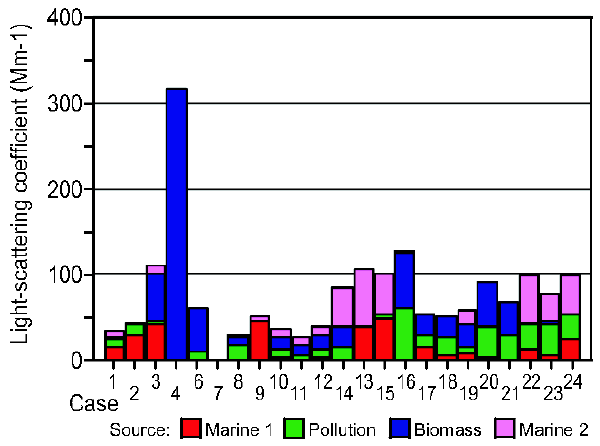
Figure 9. Source contributions to the aerosol light-scattering coefficient ( σ sp ) for each of the three sources to each of the samples taken during the CARMA III Fig. 8. Source contributions to the aerosol light-scattering coeffi- study. The samples shown were taken consecutively between August 6 th and 26 th , cient ( σ sp ) for each of the four sources to each of the samples taken 2005. during the CARMA IV study. The samples shown were taken con- secutively between 11 and 27 August 2007.